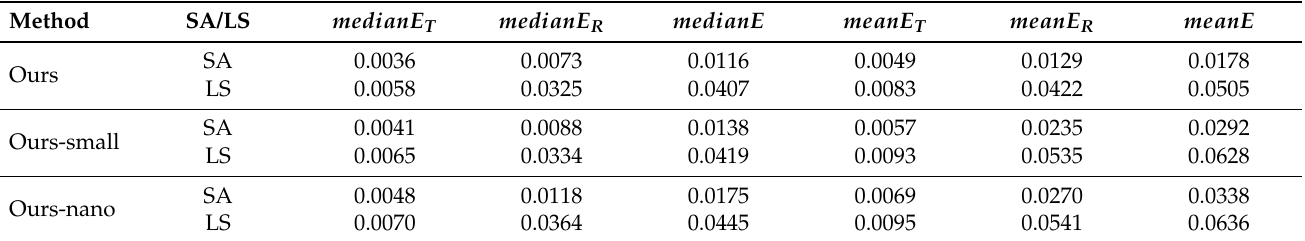
Table 4. The performance of three versions of our method on 1000 synthetic images with different 3D wireframe models from SA or Least Square